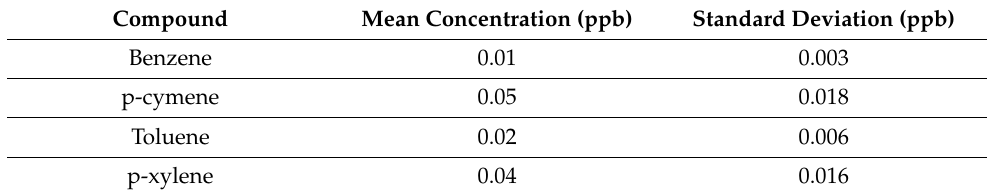
Table 2. Blank concentrations estimated from all UHP nitrogen samples during